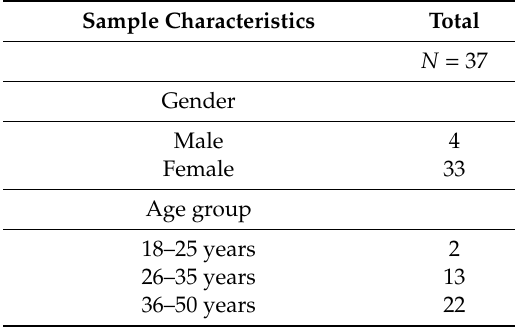
Table 2. Focus group sample